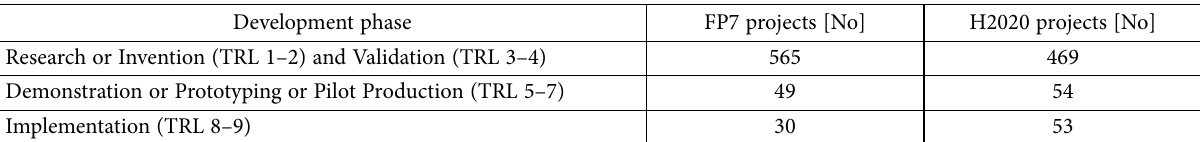
Figure 7. Extract of transport technologies developed under Framework Programmes (data as of 12/2018 subject to change): colours : blue – road; red – aviation; purple – rail; green – waterborne; abbreviations: (A in red) – aviation; (W in green) – waterborne; (R in blue) – road; ADAS – Advanced Driver Assistance Systems; EV – Electric Vehicles; EM – Energy Management; ADAM – Advanced Design And Manufacturing; CAD – Computer-Aided Design; CAVs – Connected and Automated Vehicles; Infr – infrastructure Table. Technologies addressed within Framework Programmes